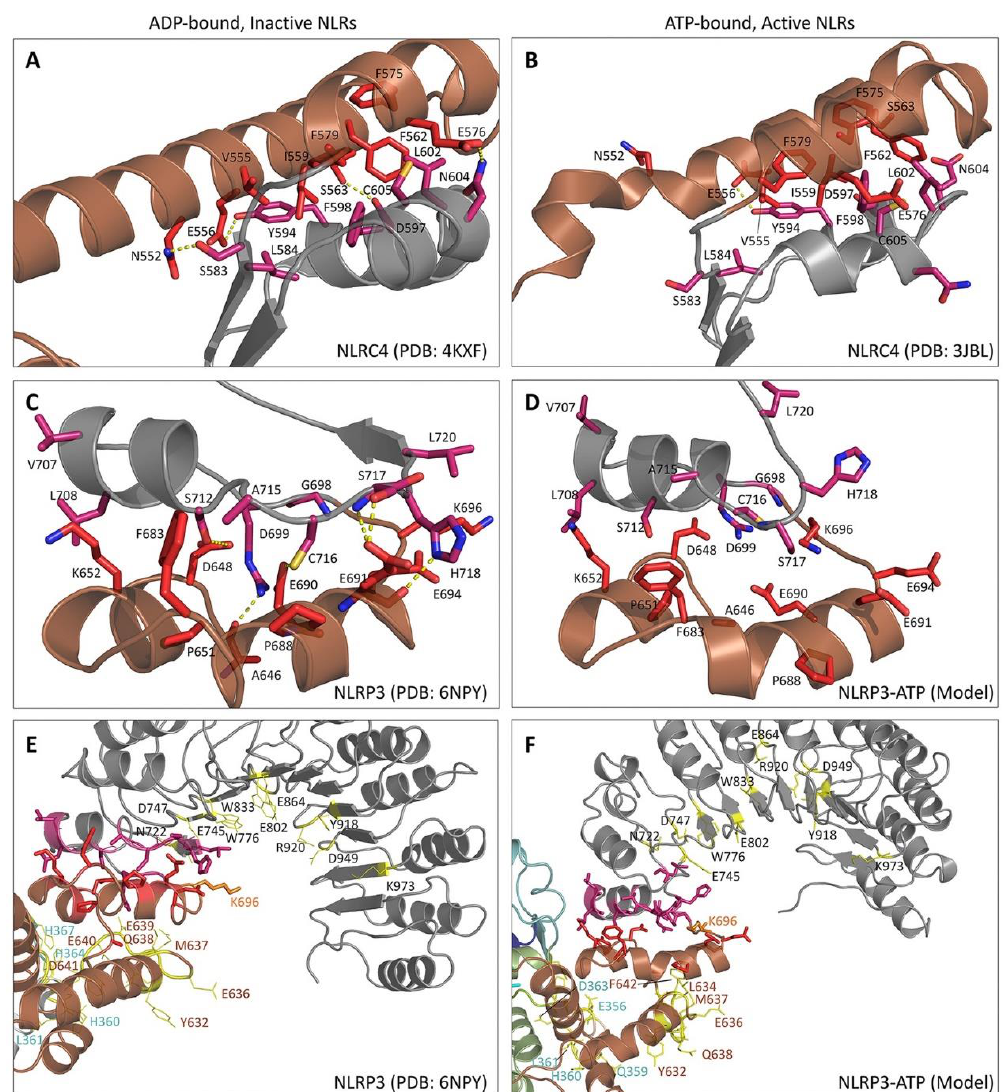
Figure 4. HD2-LRR interactions within NLRC4 and NLRP3 proteins. The detailed interaction interfaces are highlighted for the helical domain 2 (HD2, brown) and the N-terminal region of the leucine rich repeat (LRR) domain (gray). The side chains from the HD2 and LRR are coloured in pink and red respectively. Dashed yellow lines indicate hydrogen bonds. ( A ) ADP-bound NLRC4 at 3.2 Å resolution [15], ( B ) ATP-bound NLRC4 at 4.7 Å resolution [89], ( C ) ADP-bound NLRP3 at 3.8 Å resolution [73], and ( D ) representative ATP-bound NLRP3. Overview of NEK7 interfaces in NLRP3-ADP ( E ) or NLRP3-ATP ( F ). NEK7-binding residues are shown in yellow, or orange if overlap occurs with the HD2-LRR interface. In ( E , F ), labels are colour coded with respect to motifs.